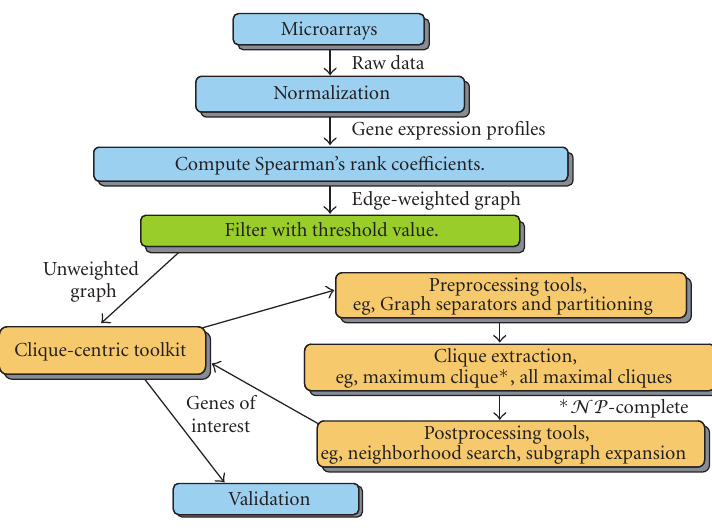
Figure 2. The clique-centric toolkit and its use in microarray